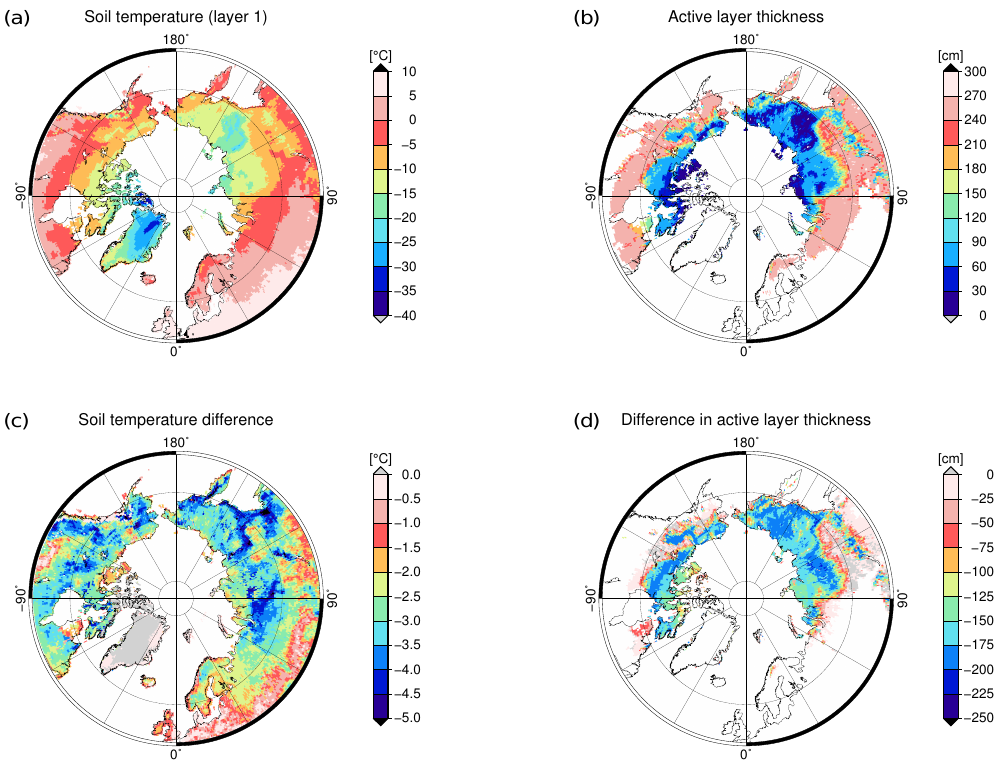
Figure 6. The maps display the spatial patterns of (a) topsoil temperature, (b) active layer thickness, (c) the temperature difference in the uppermost soil layer and (d) the difference in active layer thickness, based on average values over the last 15 years of transient simulations from 1901 to 2010. The differences are calculated by subtracting output of the Without simulation with no bryophyte and lichen layer from the Dynamic